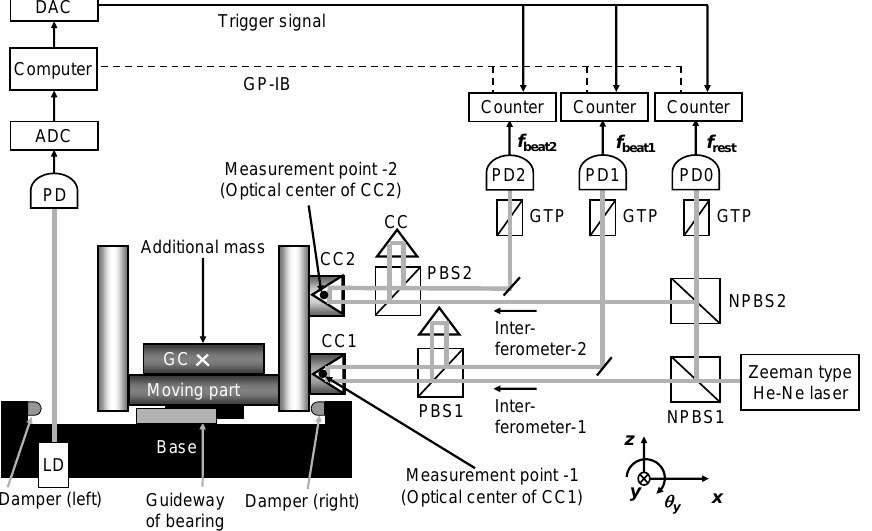
Figure 1. Experimental Setup. Code: GC = center of gravity, CC = cube corner prism, PBS = polarizing beam splitter, NPBS = non-polarizing beam splitter, GTP = Glan-Thompson prism, LD = laser diode, PD = photo diode, PC = computer, ADC = analog-to-digital converter, DAC = digital-to-analog converter.